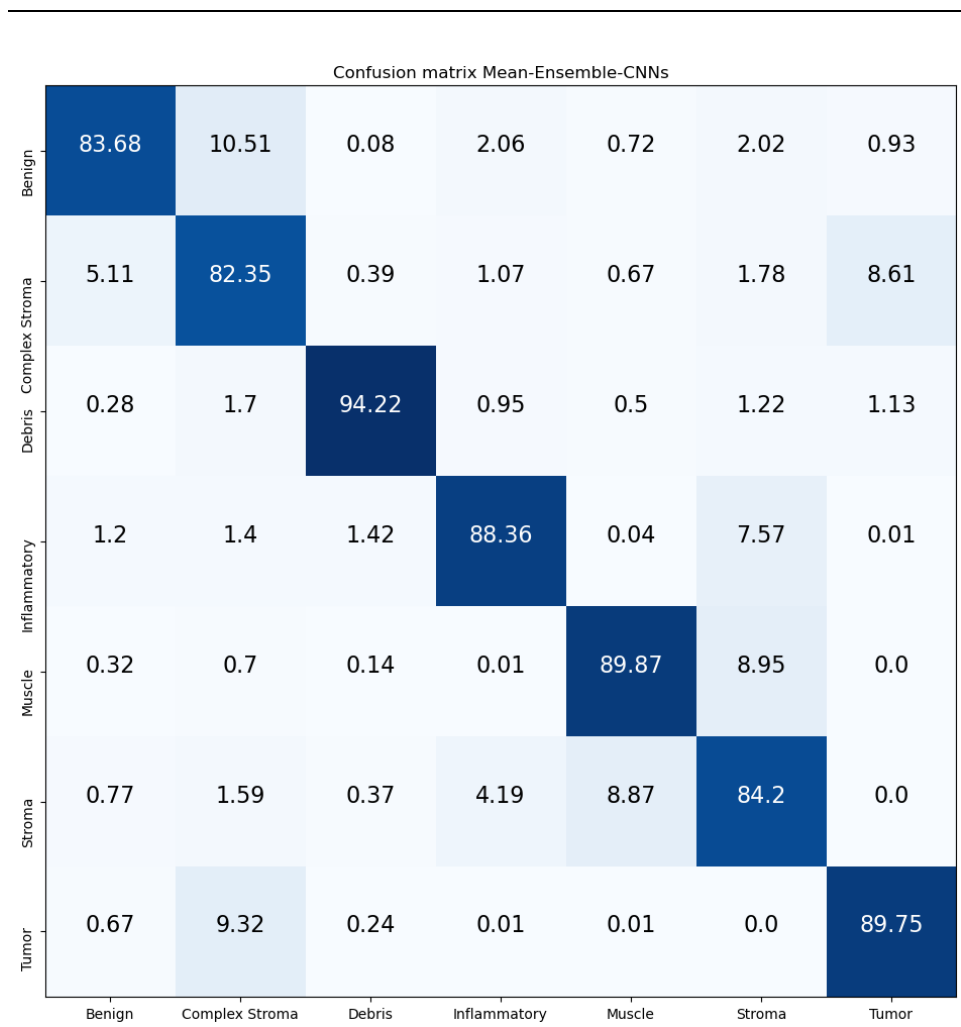
Figure 16. Confusion Matrix of Mean-Ensemble-CNNs on CRC-TP database. The vertical axis is for the true classes and the horizontal axis is for the predicted